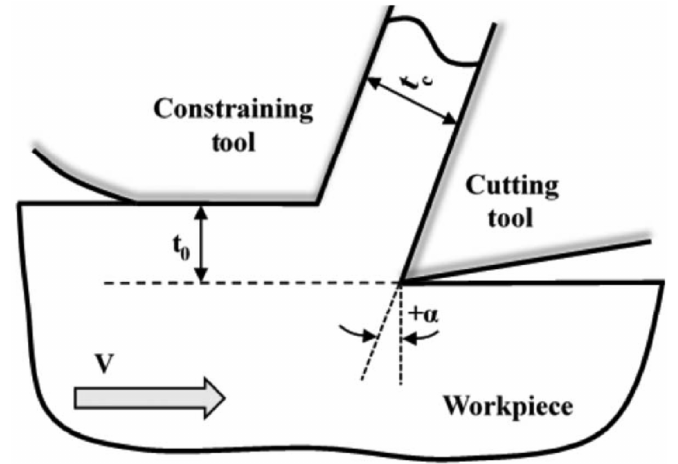
Figure 3. Schematic of large-strain-extrusion machining